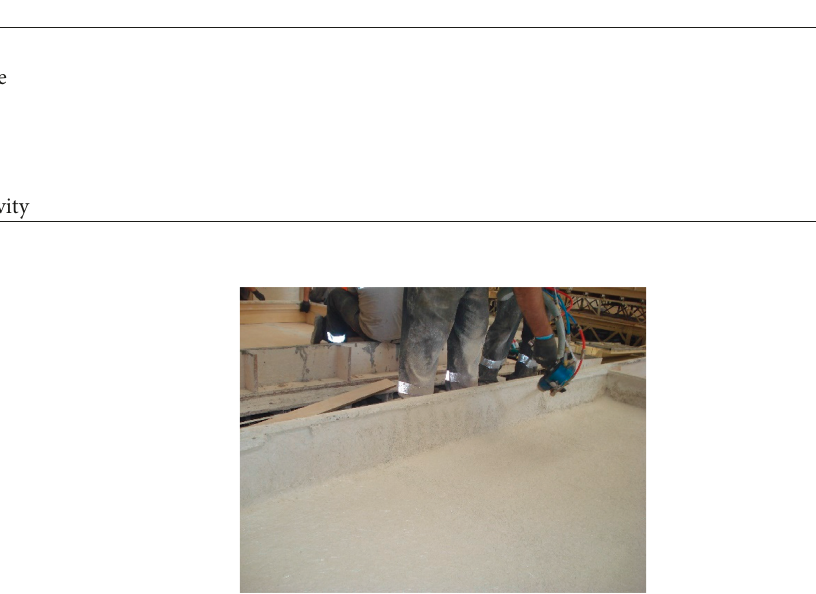
Table 1: Alkali-resistant glass fiber properties.